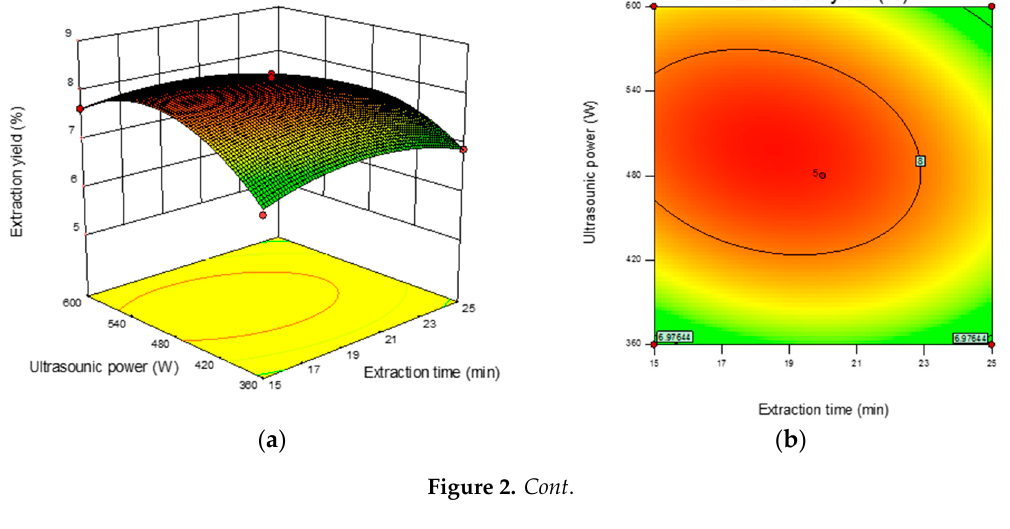
Table 2. Analysis of variance (ANOVA) testing the fitness of the regression equation.